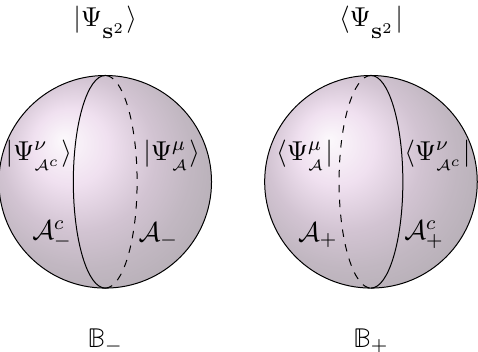
Figure 6 . Starting with the decomposition of the three sphere S 3 into two balls B (cid:0) and B + , we can identify the state j (cid:9) i ( h (cid:9) j ) as being associated with the ball B (cid:0) ( B + ). These states are obtained S 2 S 2 by canonical quantization as described earlier and are meant to live on S 2 = @ B (cid:0) (respectively @ B + ). This con(cid:12)guration of solid spheres carrying Chern-Simons path integral without any identi(cid:12)cation between B (cid:0) and B + represents total density matrix (cid:26) = j (cid:9) ih (cid:9) j . If we now further decompose S 2 S 2 the boundary of the balls into @ B (cid:0) = A [ A c , and @ B + = A + [ A c , respectively, then we obtain + reduced states on subregions of interest which we have indicated